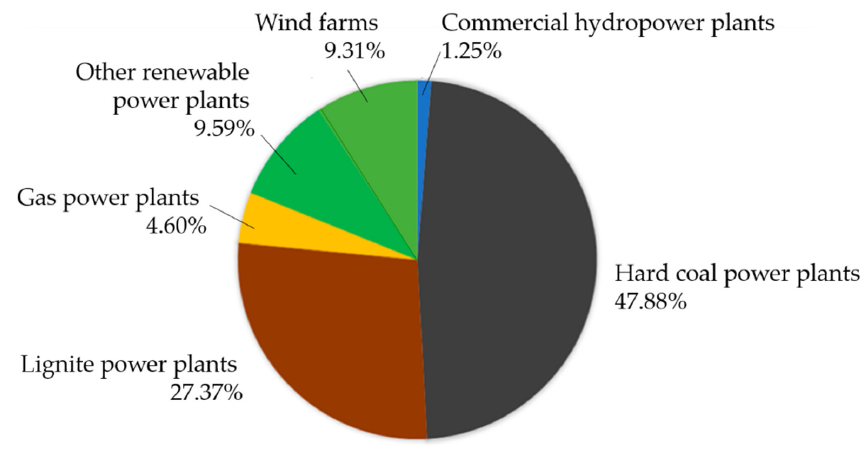
Figure 2. The structure of the electricity production in Poland in July, 2022.